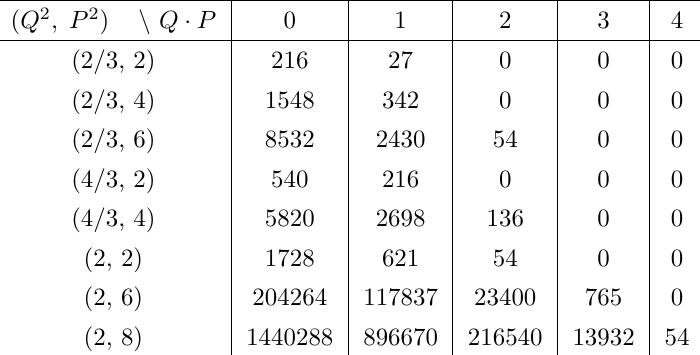
Table 5 . Index of horizon states for the 2 A orbifold of K 3 .